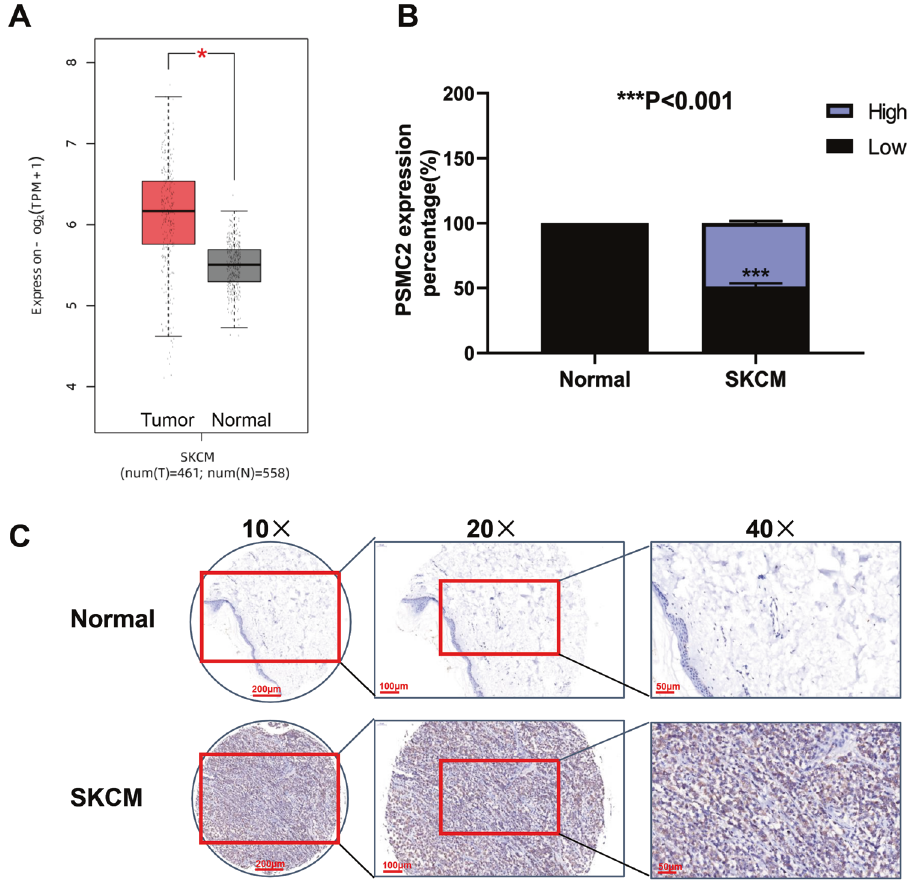
Fig. 1 PSMC2 expression in SKCM. A The expression of PSMC2 was detected from the TCGA dataset by using GEPIA2 (http://gepia.cancer- pku.cn/). Red represents tumor samples and gray means normal samples. B Immunohistochemistry (IHC) revealed higher expression patterns of PSMC2 in SKCM tissues than that in normal skin tissues. N = 105. C Representative images of IHC staining for PSMC2 expression in SKCM and normal tissues. Data were expressed as the mean ± SD. * P < 0.05 and *** P <